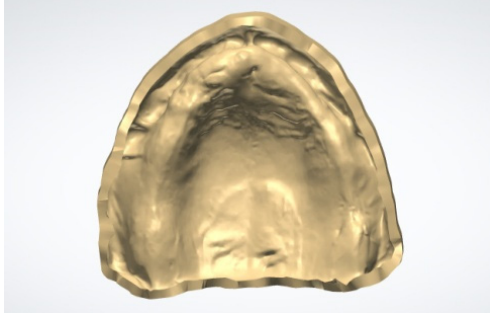
Figure 5. Digital cast of the upper edentulous jaw.